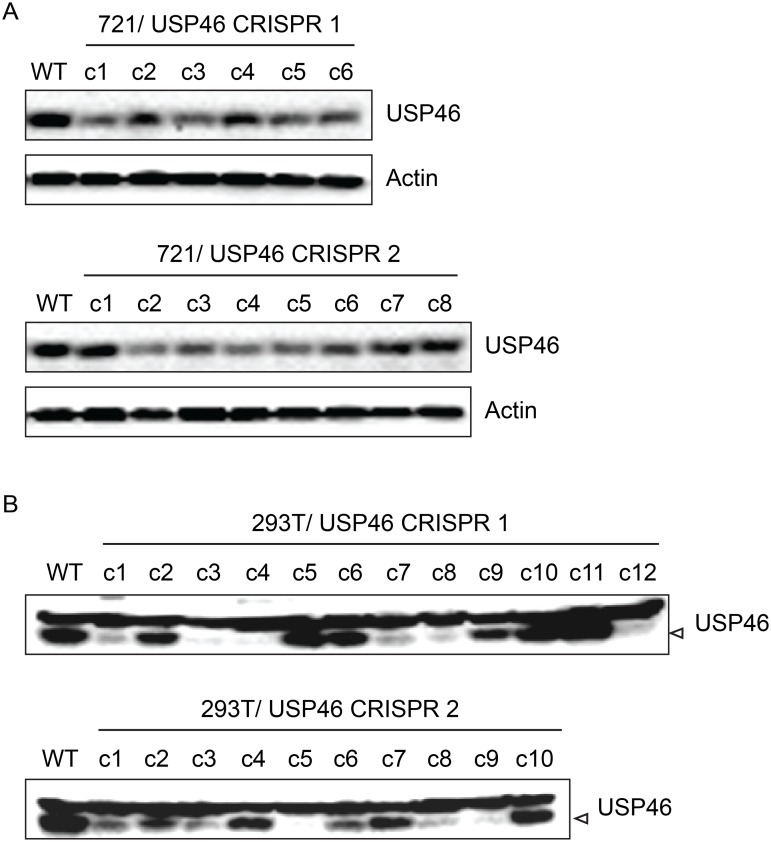
Inability to derive USP46 null LCLs using CRISPR/ Cas9 mediated gene editing.(A) Western blot for USP46 in 721 LCLs cells transfected with a plasmid expressing either of two guide RNAs targeting different USP46 exons (CRISPR 1 or CRISPR 2) and a hygromycin resistance gene. Prior to harvesting, cells were subjected to hygromycin selection for one month (resulting in 6 clones for CRISPR 1 and 8 clones CRISPR 2). Untransfected 721 cells are also shown (WT). As a loading control, lysates were probed for beta actin (bottom panel). (B) Western blots of 293T cells that were transfected same CRISPR plasmids as in panel A and also subjected to one month of hygromycin selection. Hygromycin resistance cells were harvested and blotted for USP46 (specific band is indicated by arrowhead). Untransfected 293T cells are also shown (WT).